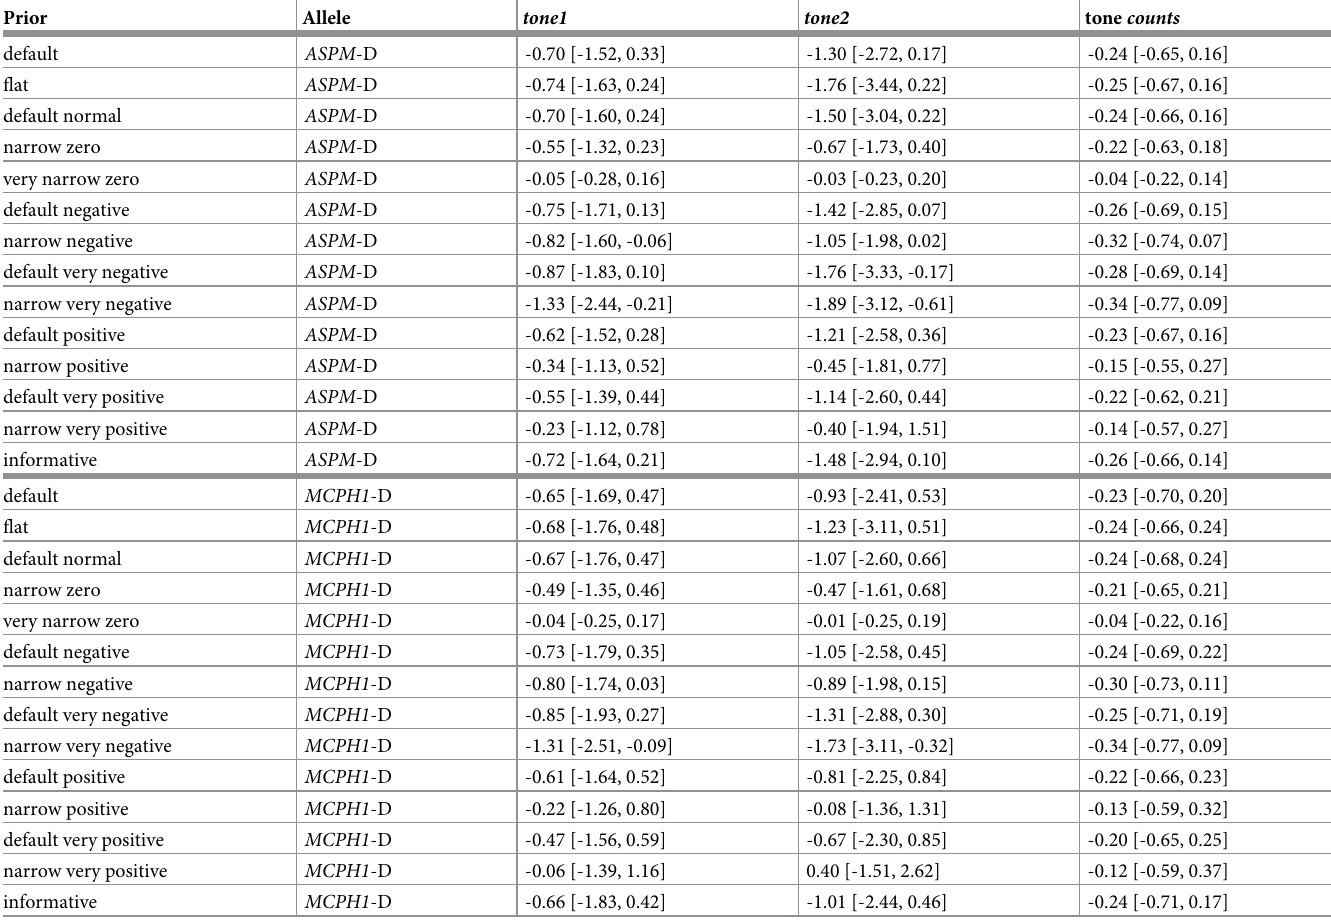
Table 16. The results of the prior sensitivity analysis. Showing the point estimate and 89% HDI of the slope β for each of the three DVs ( tone1 , tone2 and tone counts ) and two IVs ( z -scored population frequency of ASPM -D and MCHP1 -D). See Table 15 for prior